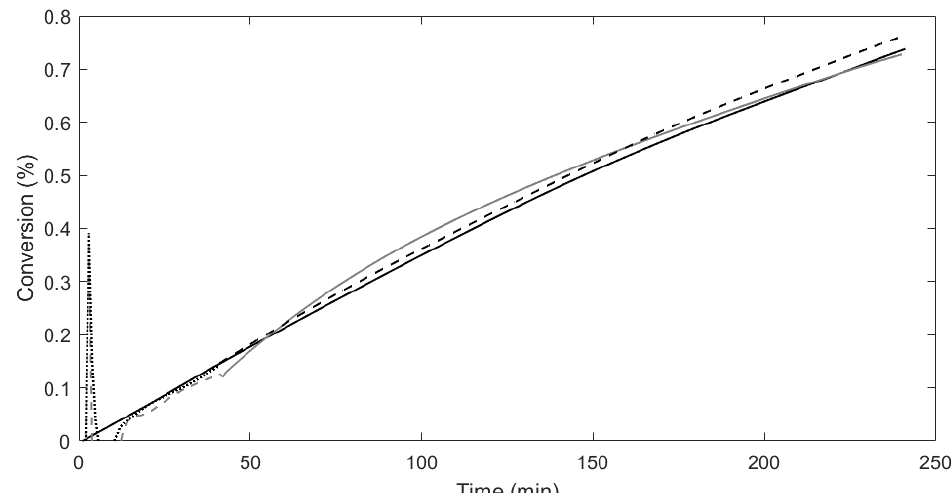
Figure 4. The conversion predictions from both models with every tenth quality measurement retained and 20% missing output data. The dashed grey lines represent estimates made by the Luenberger observer until the 40th minute and the solid grey line shows the predictions from the proposed approach in comparison to the process, represented by the solid black line. The dotted and dashed black lines show the estimates made by the Luenberger observer and traditional subspace identification using linear interpolation, respectively.